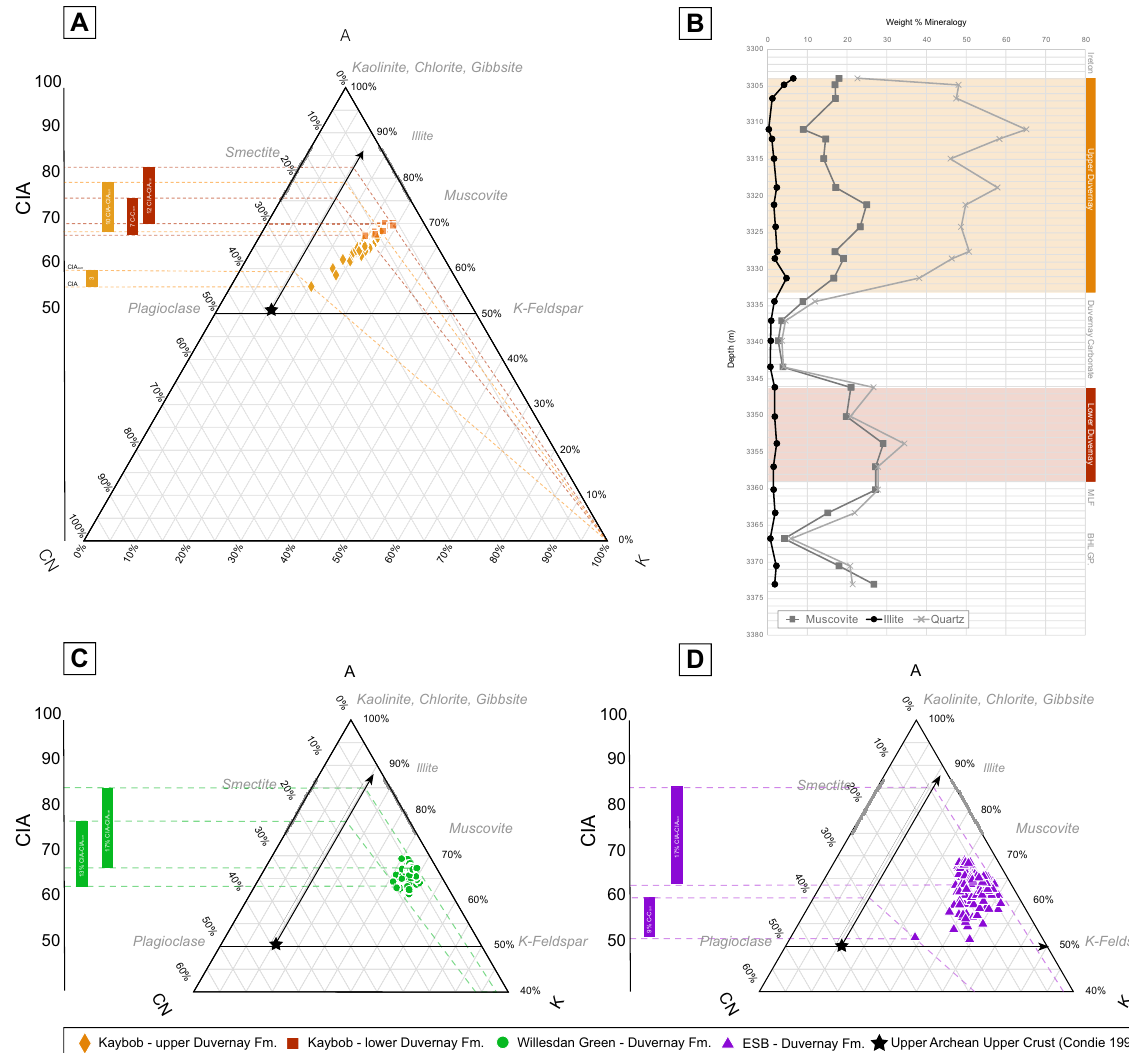
Figure 5. A-CN-K (A1 2 O 3 –CaO* + Na 2 O–K 2 O) plots of Kaybob well ( A ) and XRD data versus depth ( B ). The chemical alteration index (CIA) is used to find the level of diagenetic alteration the samples have experienced 44–48 . Samples are plotted back to the weathering trend along a diagenesis line (from K 2 O), to the weathering trend and over to the CIA (CIA corr ) 46 to correct for K-enrichment. The CIA-CIA corr of the sample determines the level of K-enrichment for each sample. The highest values of CIA-CIA corr are noted here for each